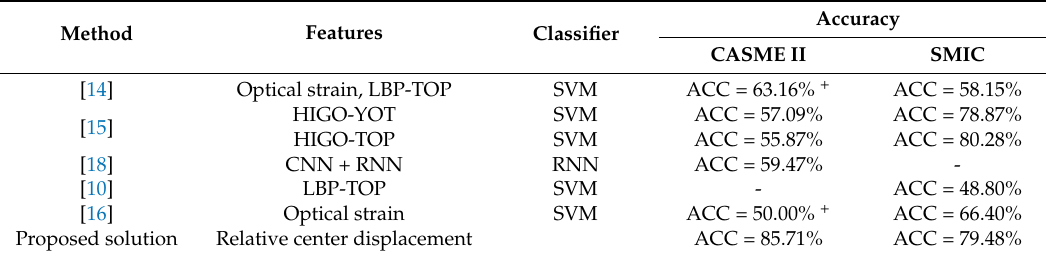
Table 7. ME recognition performance—comparison with state of the